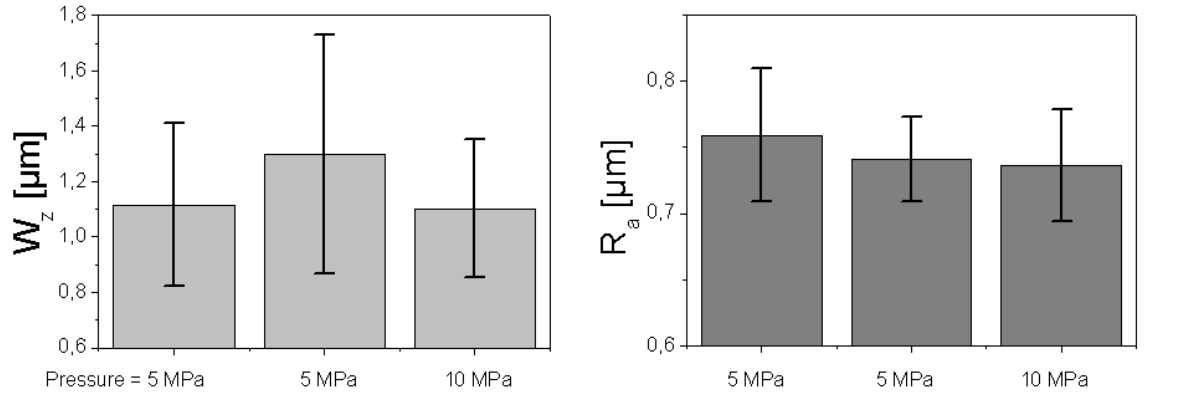
Figure 9. Influence of moulding conditions (pressure, moulding time) on meso (W N ) and micro topography (R z